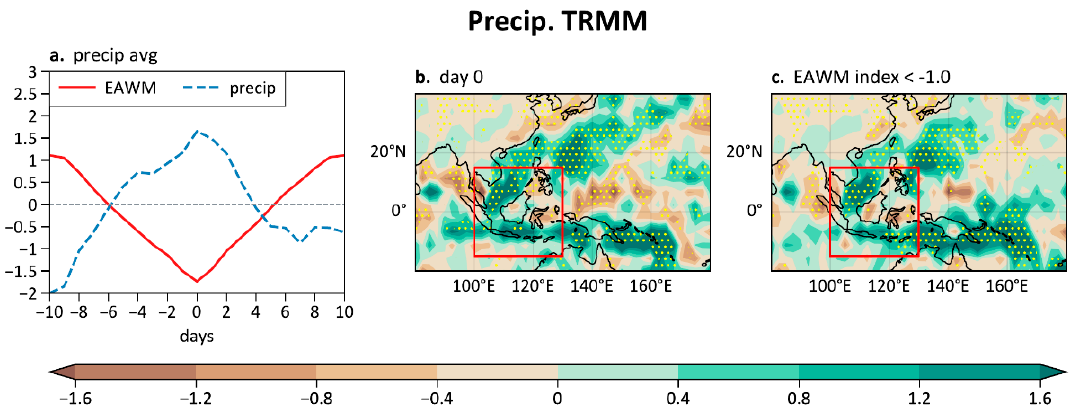
Figure 6. ( a ) Temporal evolutions of the composite EAWM index and area-averaged TRMM precip- itation anomaly (normalized) in the WTP region (15°S − 15°N, 100° − 130°E, shown as red box in b ) during the strong EAWM events. ( b ) Composite anomalies of TRMM precipitation for day 0 of the strong EAWM events. It should be noted that there are 17 strong EAWM events, that is, 17 “day 0” samples, within the temporal coverage of TRMM (1998–2019). ( c ) Composite anomalies of TRMM precipitation for days when the EAWM index is less than –1 std. It should be noted that there are 111 days which meet the above criteria. Stripping regions in b and c indicate that the precipitation anomalies exceed the 95% confidence